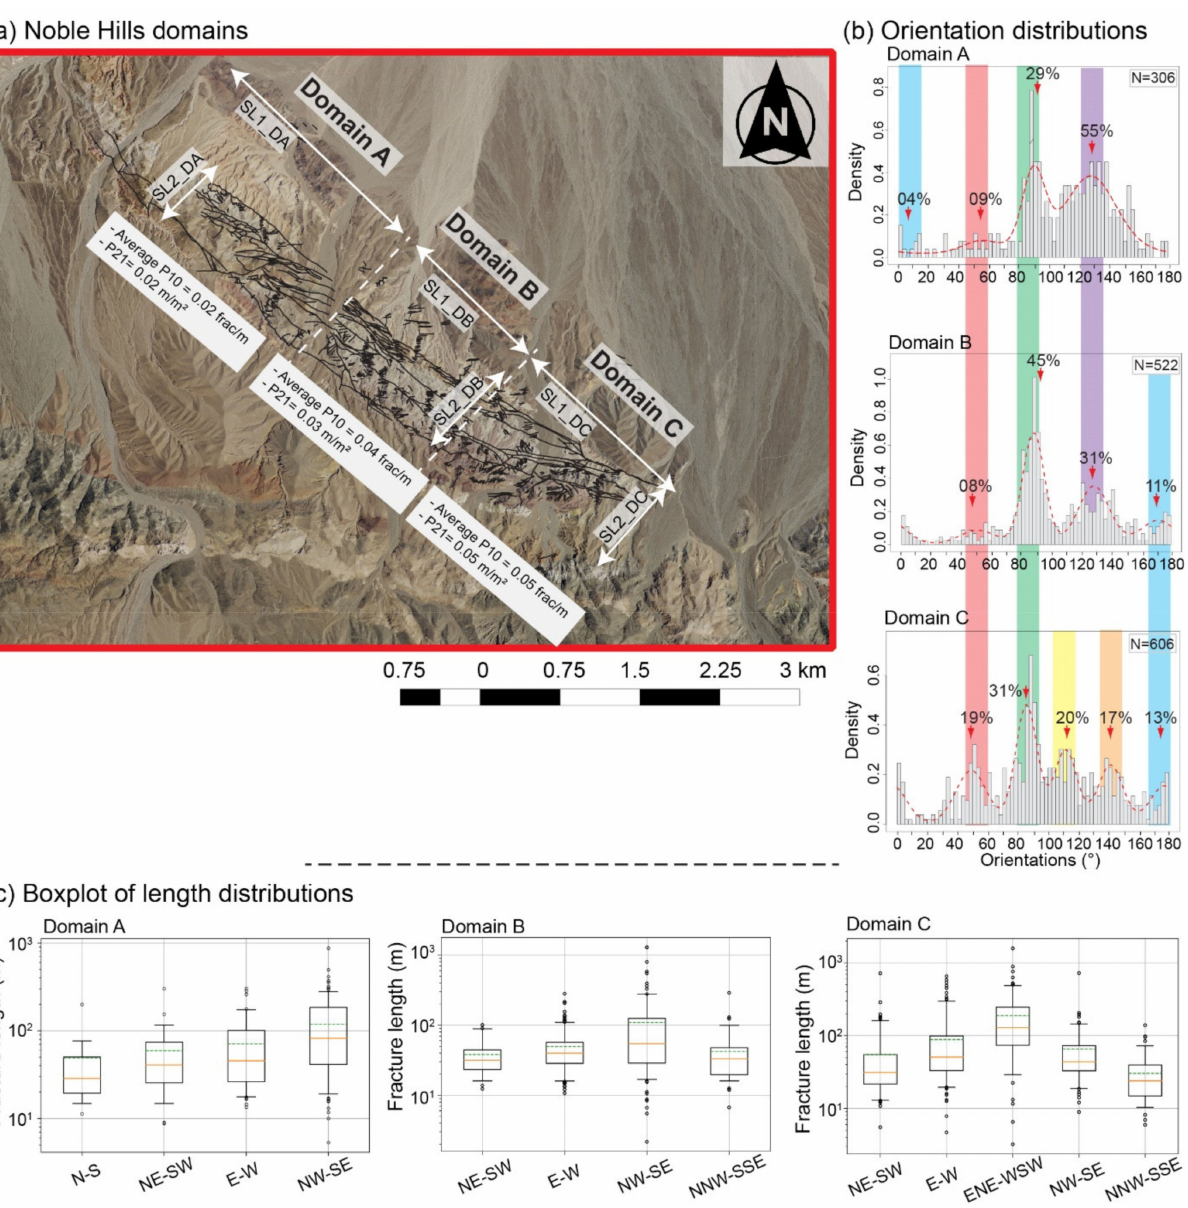
Figure 3. Fracture traces from the NH range divided into 3 domains. ( a ) NH domains: A, B, and C, ( b ) orientation distributions, and ( c ) boxplot of length distributions according to the fracture orientations. Two scanlines (SL) were taken for every domain. For boxplot and orientation distribution legend, see Figure